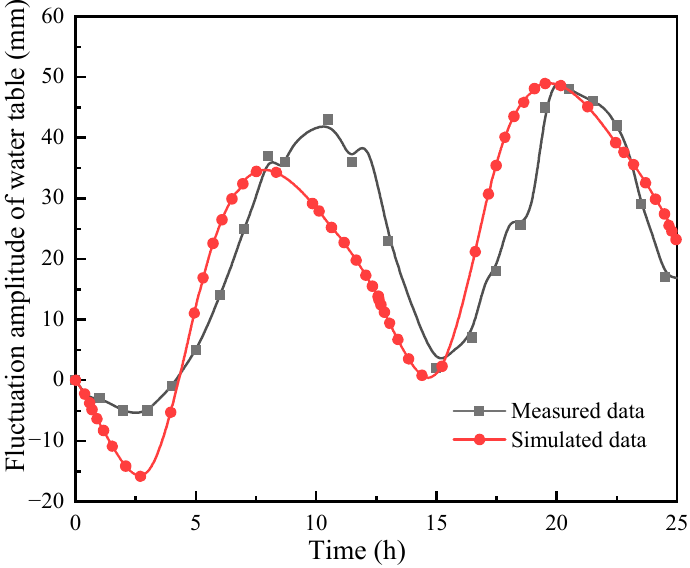
Figure 5. Measured and simulated data of fluctuation amplitude of water table.